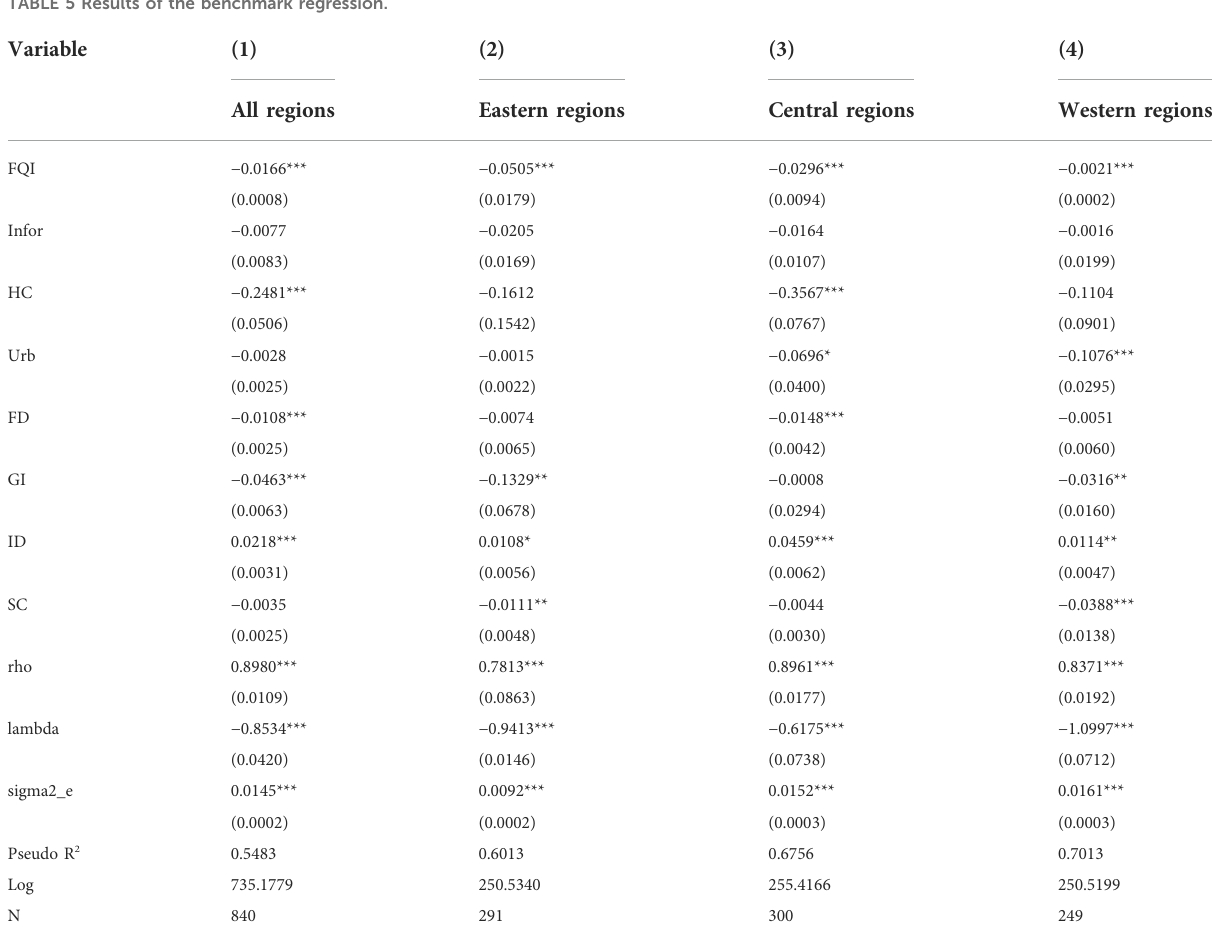
TABLE 5 Results of the benchmark